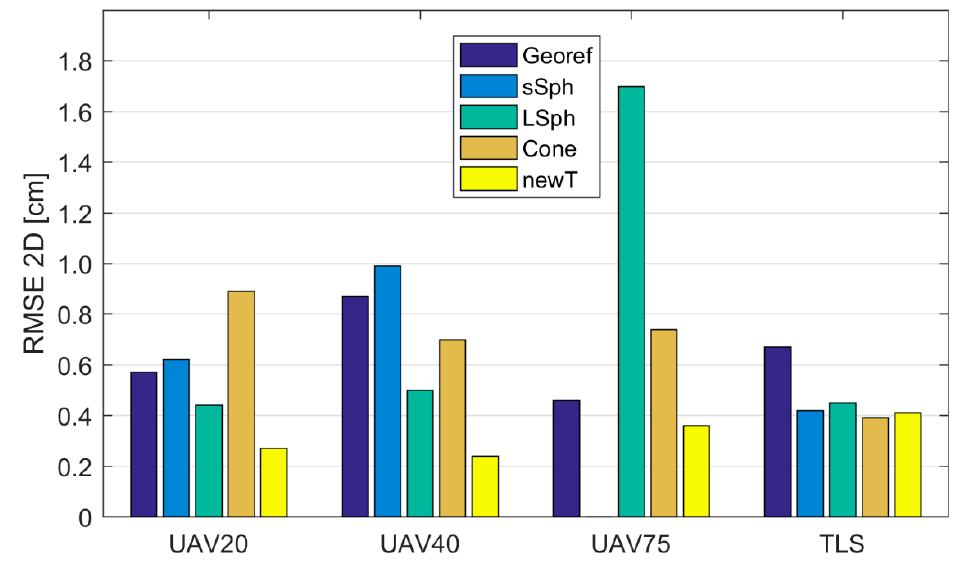
Figure 16. The RMSE 2 D of the check points following the UAV and TLS point cloud registration into Figure 16. The 𝑅𝑀𝑆𝐸 (cid:2870)(cid:3005) of the check points following the UAV and TLS point cloud registration into the referential measurements performed with the referential measurements performed with MS50.